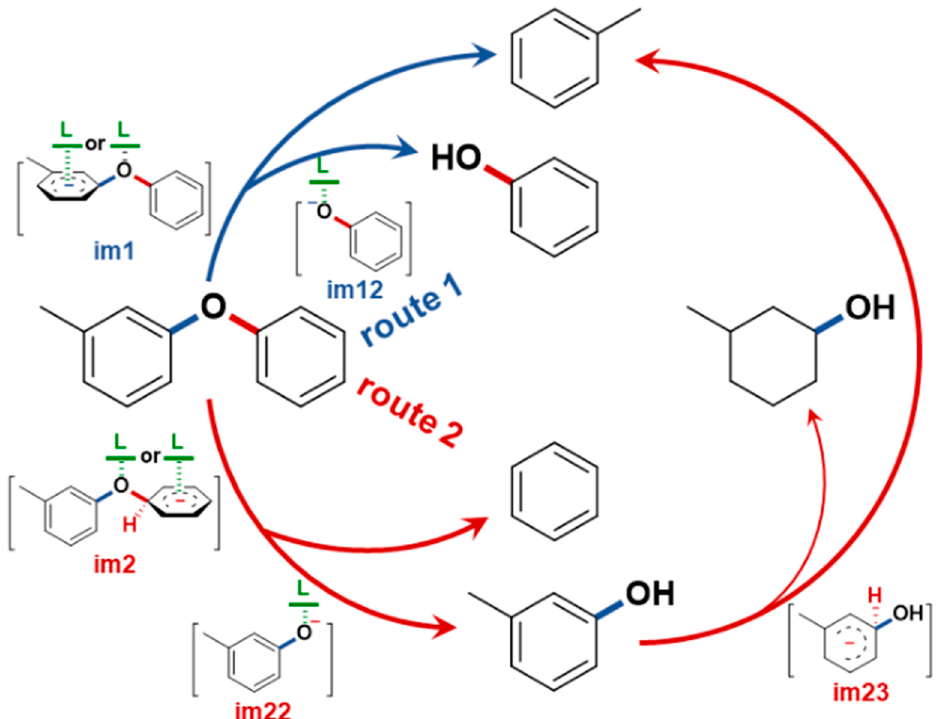
Table 3. Hydrogenolysis of different model compounds over Ru-Ni 12 P 5 /S-1 5